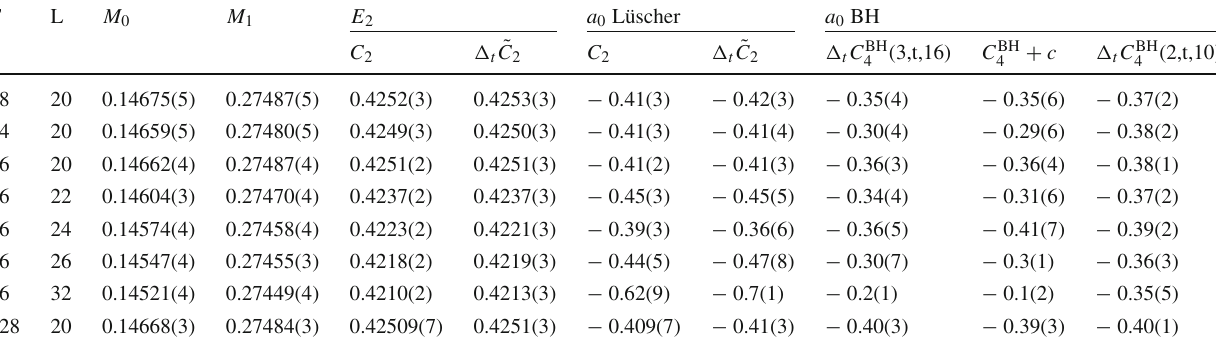
Table 1 Values of a 0 , M 0 , M 1 and E 2 measured. The column (cid:6) t C BH corresponds to the value of a 0 fitted with Eq. (4) fixing t i = 3 and t f = 16 or t i = 2 and t f = 10, the column C BH + c is the result of the fit Eq. (3) adding a constant term. The two-particle energy E 2 is computed from C 2 with the fit of Eq. (6) and from (cid:6) ˜ C 2 with Eq. (8). The corresponding value of a 0 computed with the Lüscher method is reported in the corresponding columns. We used 2 · 10 7 configurations